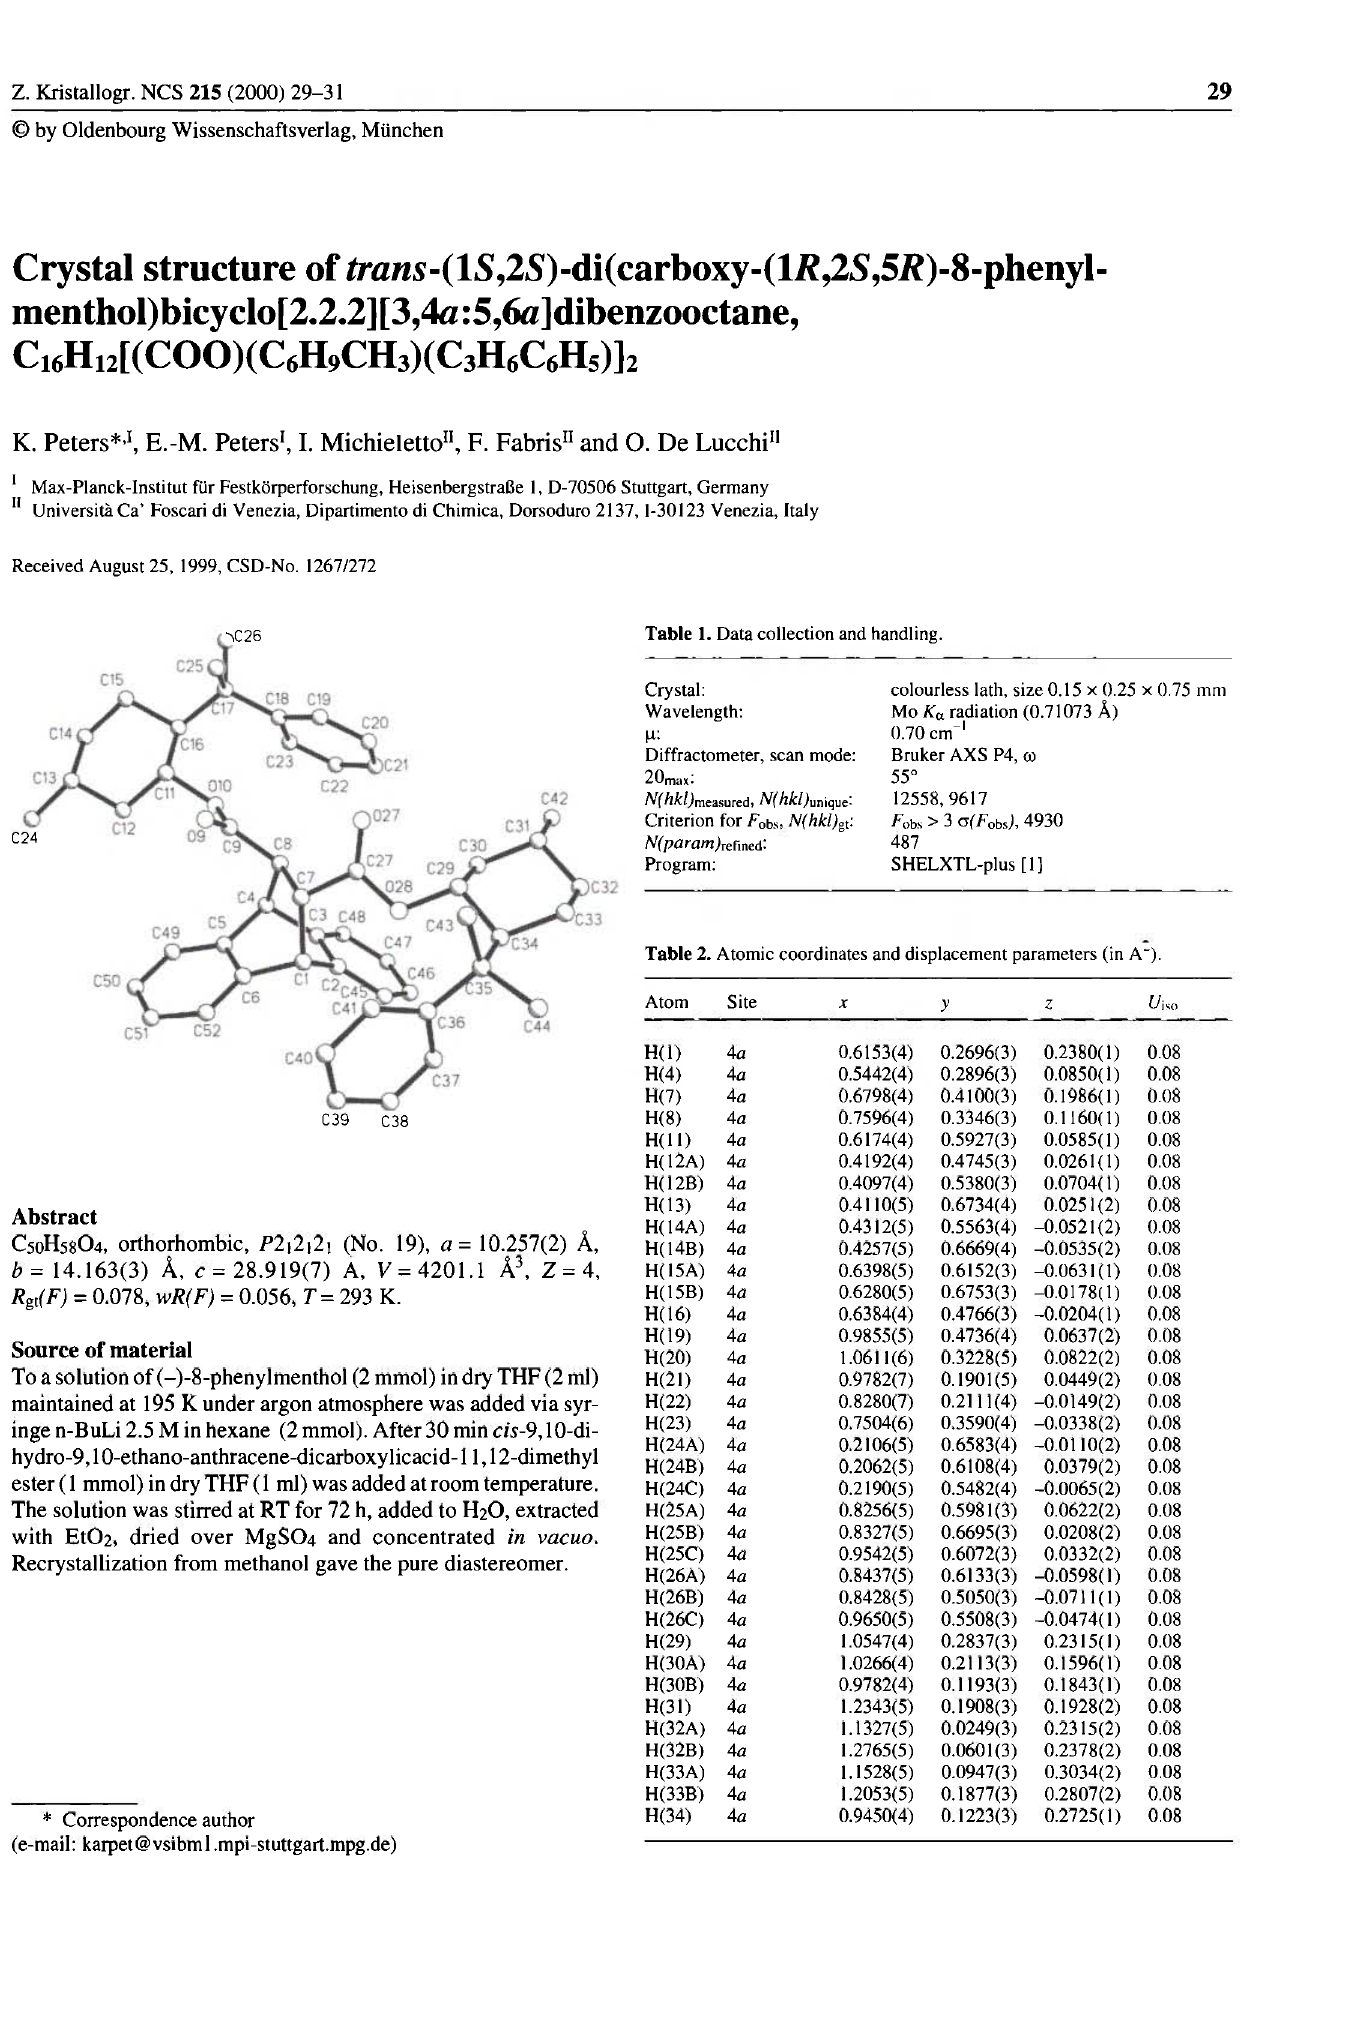
Table 1. Data collection and handling.